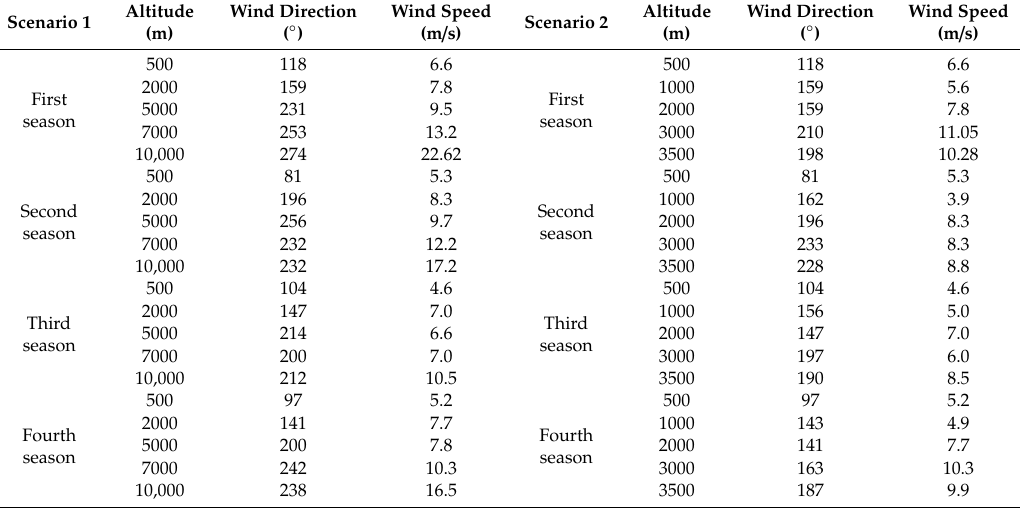
Table 4. Wind direction and speed data used for the simulation of the two eruptive scenarios. Note that the wind direction is expressed by angle (0 ◦ represents the North wind, 90 ◦ the East wind, 180 ◦ the South wind, and 270 ◦ the West